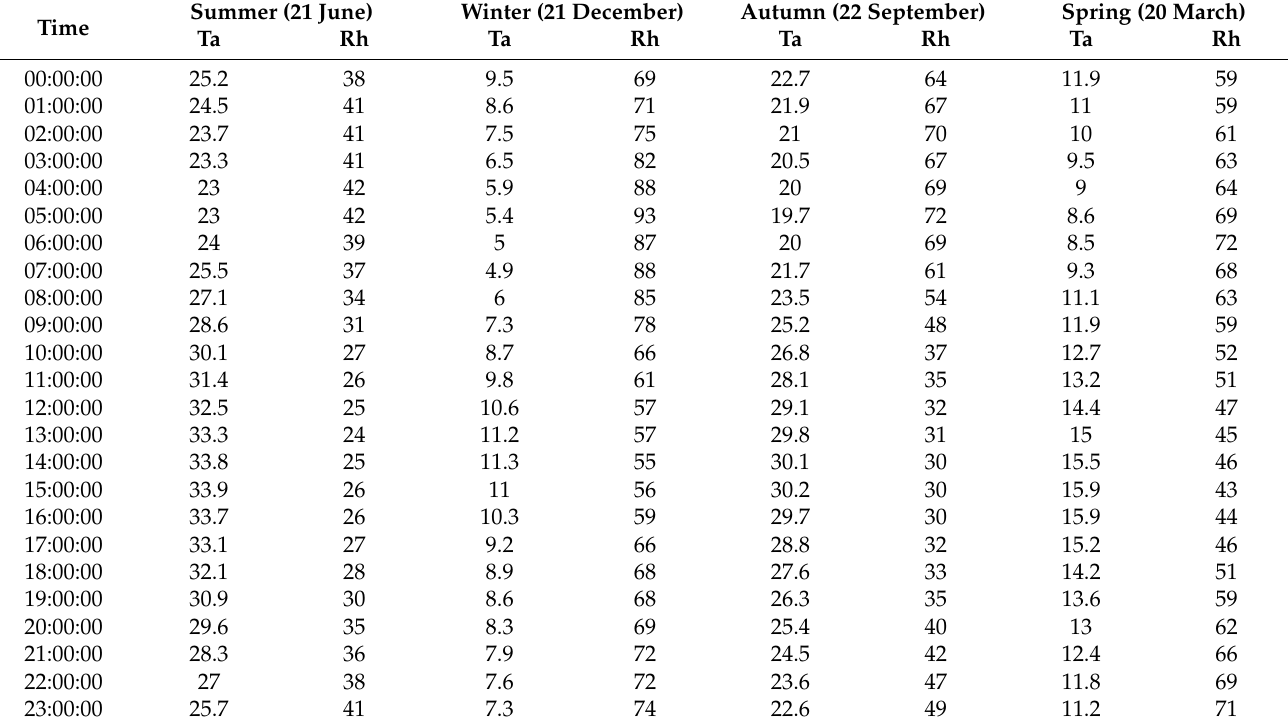
Table A1. Air temperature and relative humidity values for each seasonal simulation.